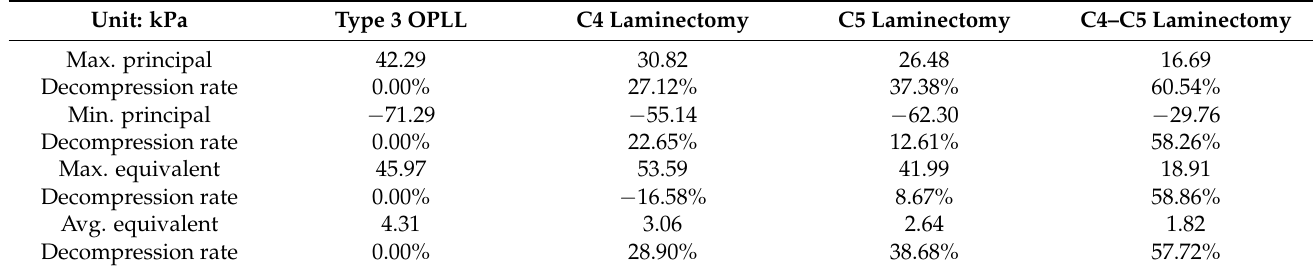
Table 6. Neutral laminectomy simulation spinal cord stresses: type 3